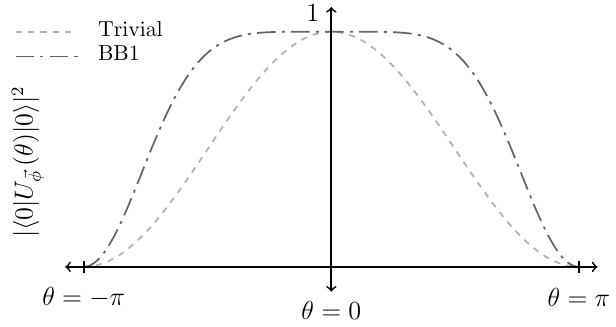
FIG. 1. The transition probabilities for | 0 (cid:6) → | 0 (cid:6) after the application of exp ( i θ X / 2 ) (uniform dashed) and the QSP sequence for the BB1 protocol (dotted dashed). The latter tran- sition probability is seen to be near one for a wider range of θ